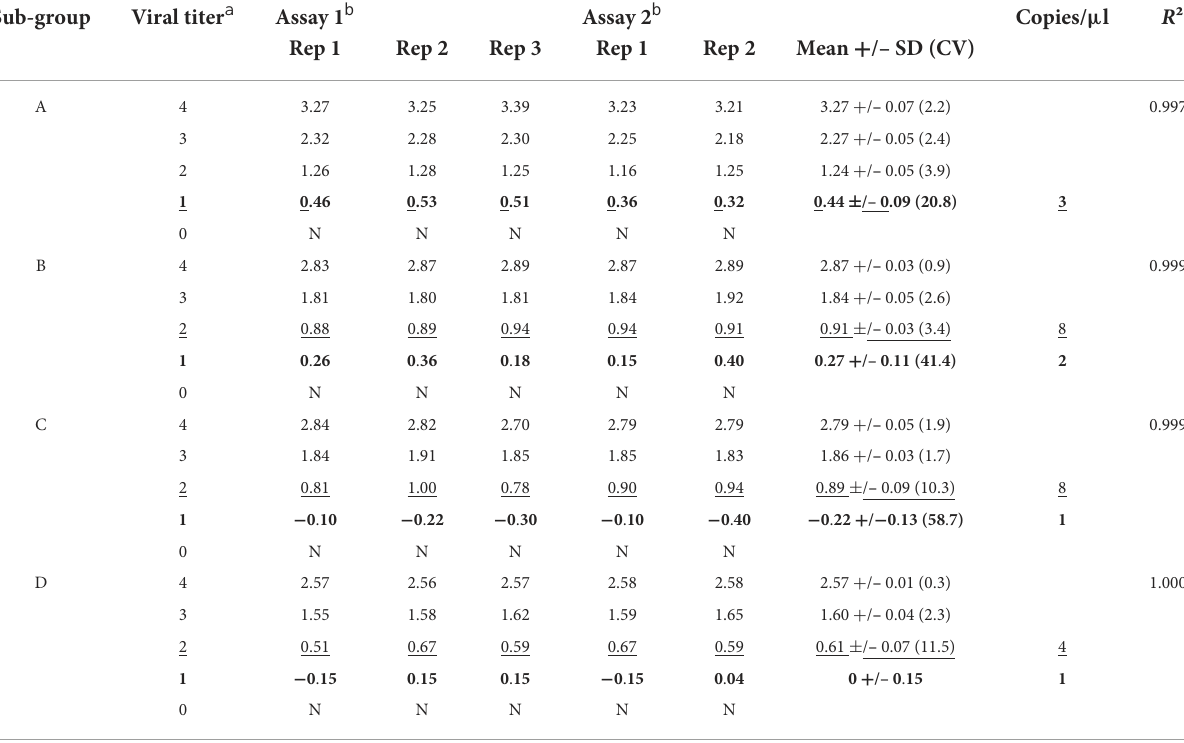
TABLE 5 Limits of detection and quantification.